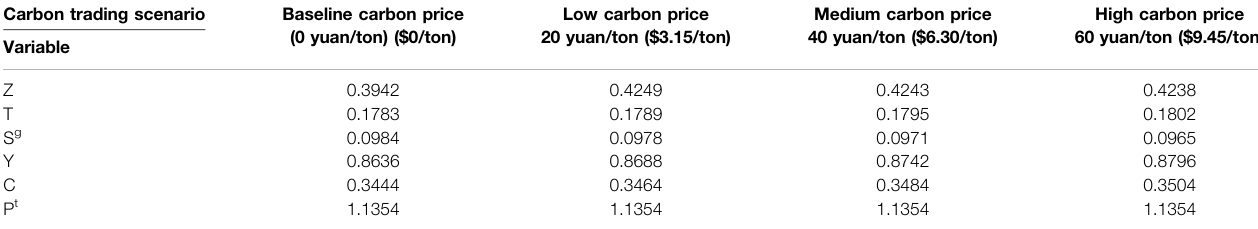
TABLE 5 | Simulation results in the carbon trading policy scenario. Carbon trading scenario